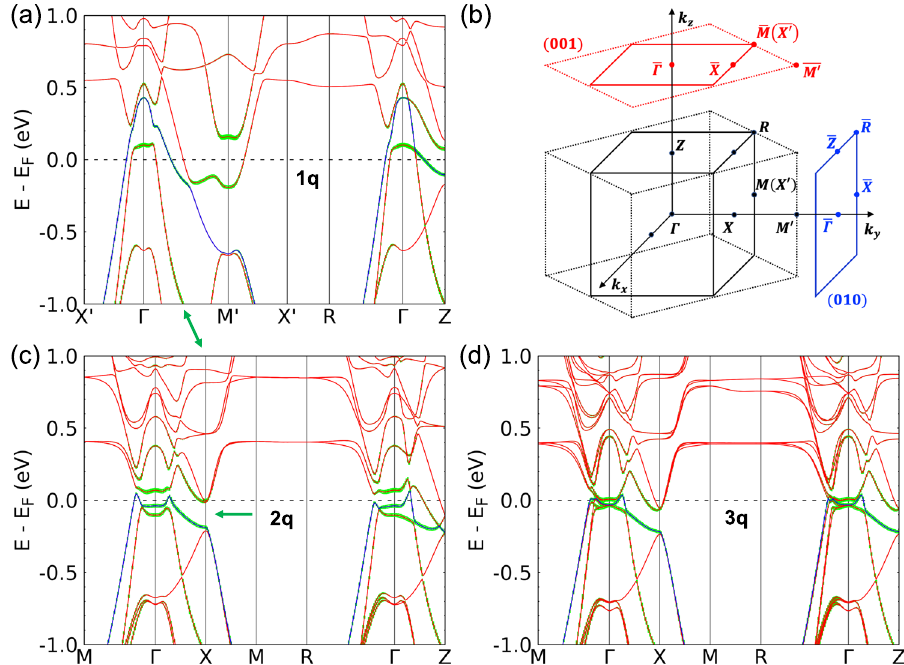
Fig. 2 Calculated bulk band structures of NdBi. a 1q, ( c ) 2q and ( d ) 3q are plotted with respect to the Fermi energy (E F ) at 0.0 eV. The top valence band is in blue and the green shade stands for the projection of Bi p orbitals. b 3D bulk Brillouin zone (BZ) of 1q (dashed lines for the tetragonal unit cell) and that of 2q and 3q (solid lines for the cubic unit cell), and the 2D surface Brillouin zone (SBZ) of (001) and (010) with the high-symmetry points labeled. The green vertical arrow in ( a ) points to band-folding at the X point, half-way along the Γ -M ’ direction for 1q. The green horizontal arrow in ( c ) points to hybridization gap opening upon band-folding along the Γ -X direction for